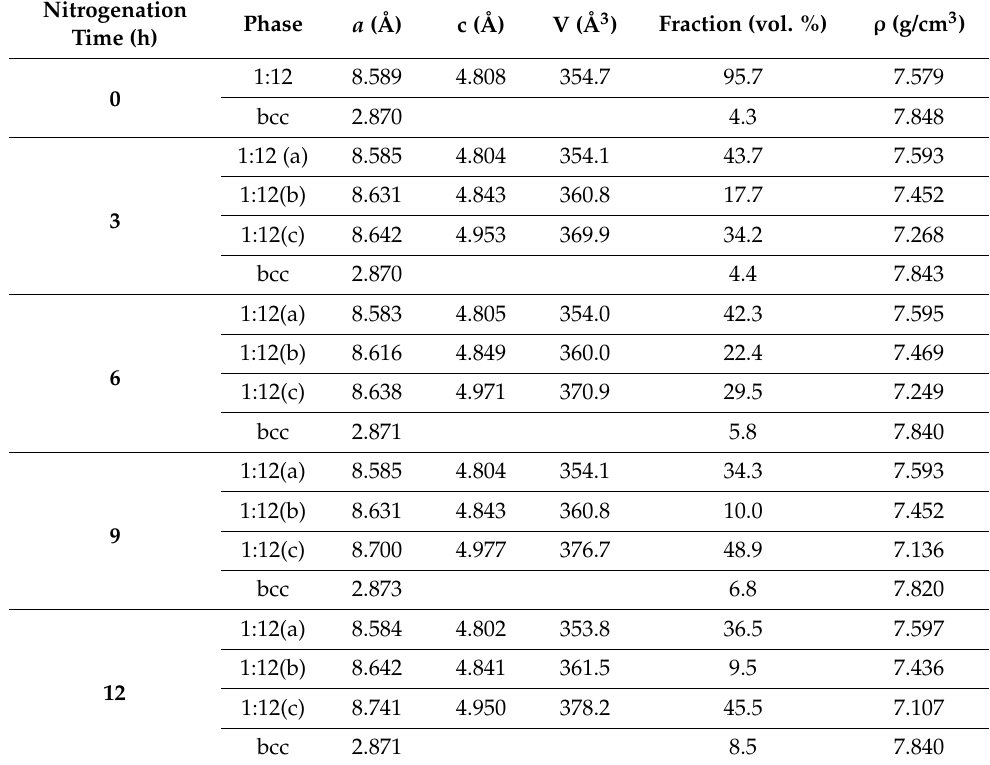
Table 1. Lattice parameters, unit cell volume V, volume fraction and density ρ , for phases in the of